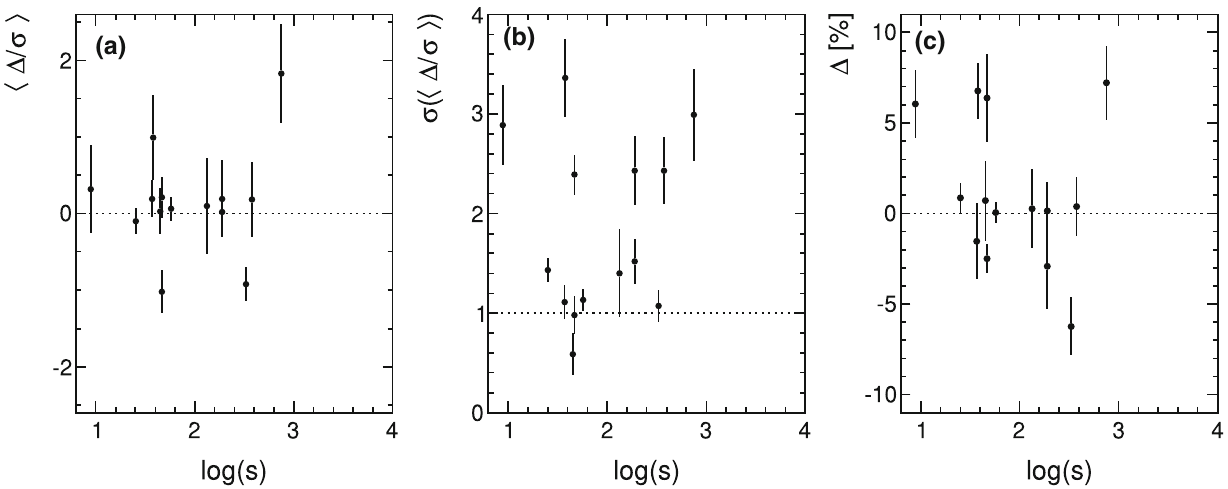
Fig. 56 a Distribution of re-normalization factors applied for the data Figs. 42, 43, 44, 45, 46, 47, 48, 49, 50, 51, 52 and 53, b mean normalized residuals after re-normalization, c the corresponding variances as a function of log ( s